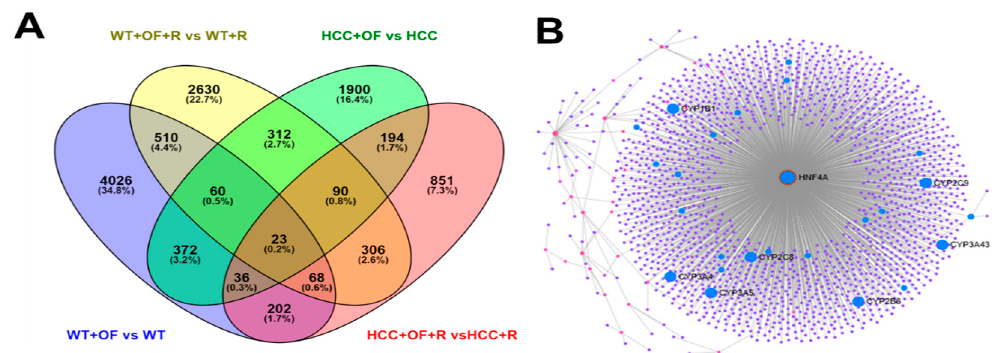
Figure 8. GeneTitan array analysis of expression profiles of wild-type and HBx , src transgenic zebrafish following di ff erent treatments. ( A ) Venn diagram of overlapping di ff erentially expressed genes. ( B ) HNF4A is the driver gene according to NetworkAnalyst (https: // www.networkanalyst.ca / ).